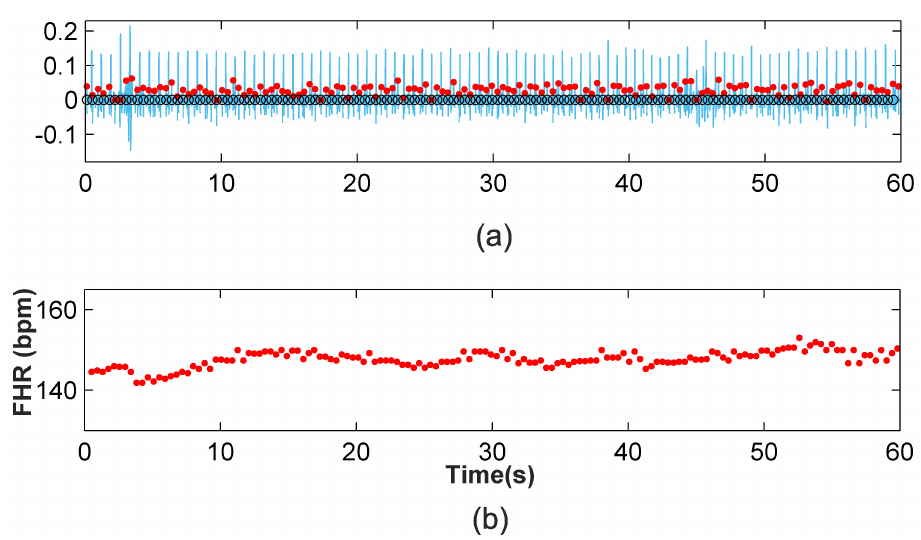
Fig 10. Application of the new method to the a49 Ab-2 recording. (a) Fetal RS detection after classification improvement and FP and FN correction (b) One-minute FHR monitoring for a49 Ab-2 recording.